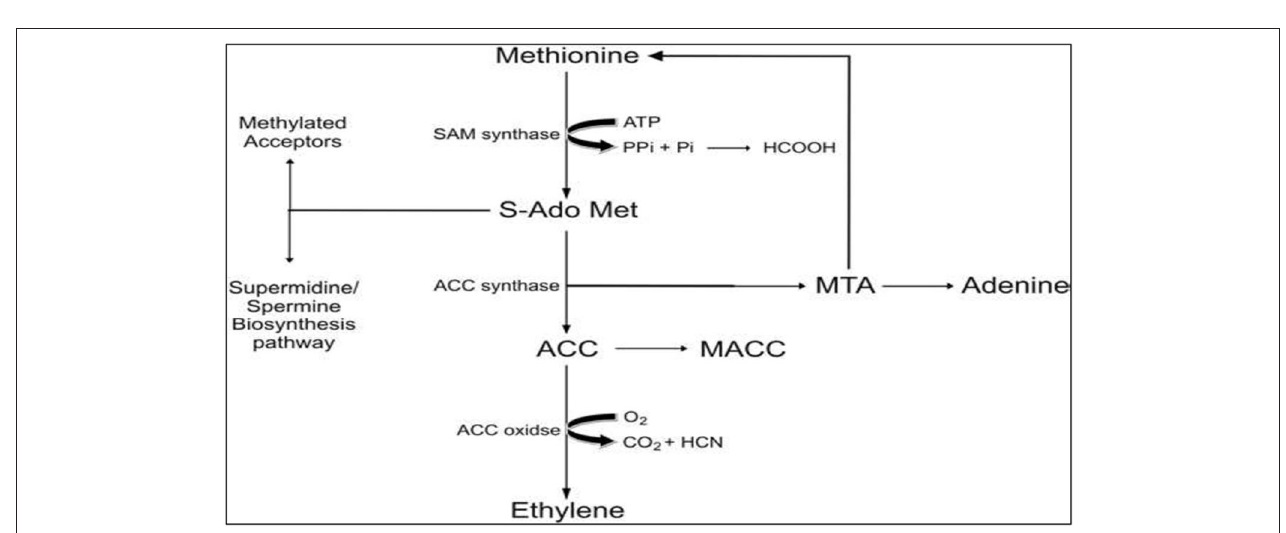
FIGURE 2 | Biosynthesis of ethylene in plant